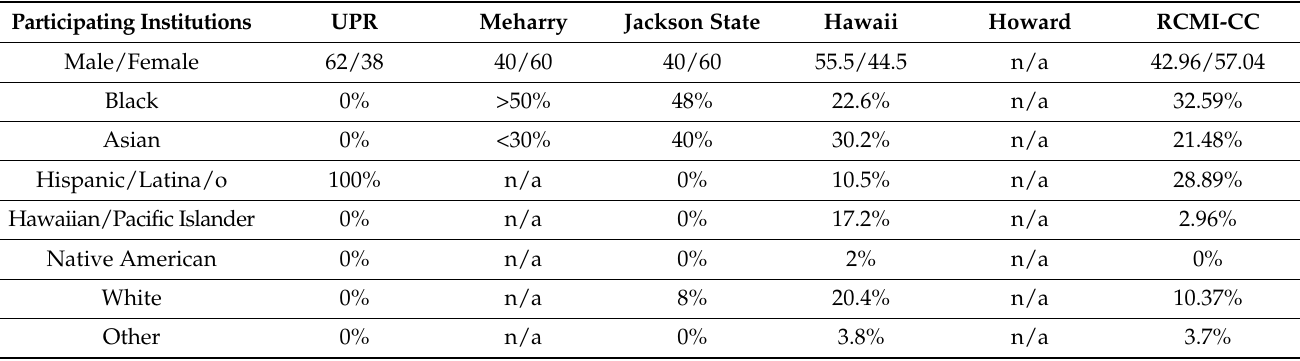
Table 3. Demographic Summary of participants served through programmatic